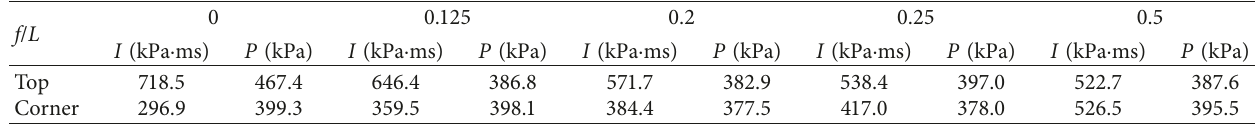
Table 6: Results of parameter analysis with different rise-span ratios.